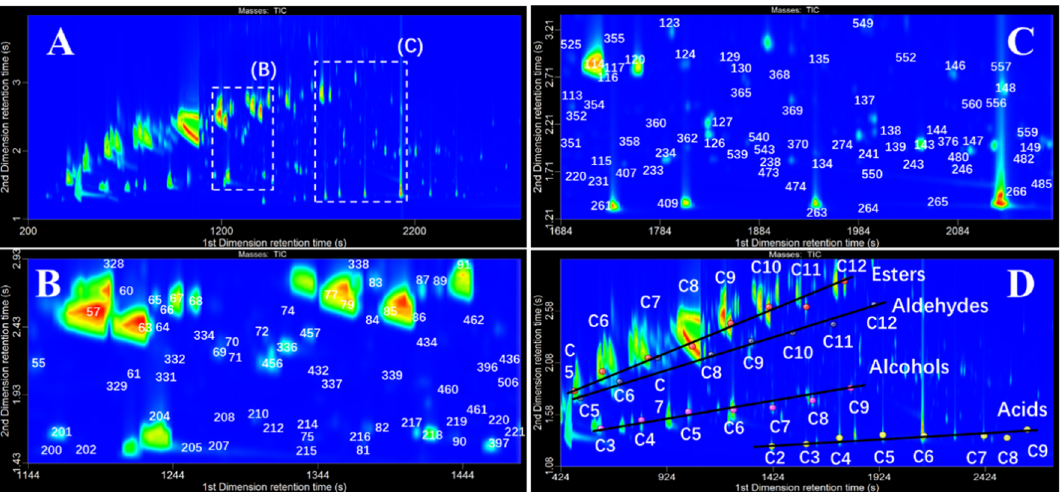
Figure 1. ( A ) Complete 2D contour plot; ( B ) and ( C ) present detailed portions of the contour plot to